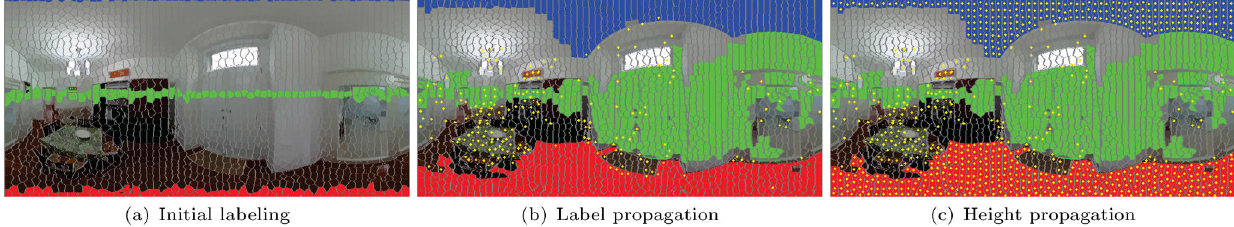
Fig. 2 Image labeling and feature propagation. (a) Initialization of the labeling process, which assigns regions of the image to ceiling (blue), floor (red), wall (green) zones, leaving undecided areas as unknown . (b) Labeling after conservative propagation; we highlight super-pixels for which the height is known from the multi-view registration (yellow centroids). (c) Final propagated heights.